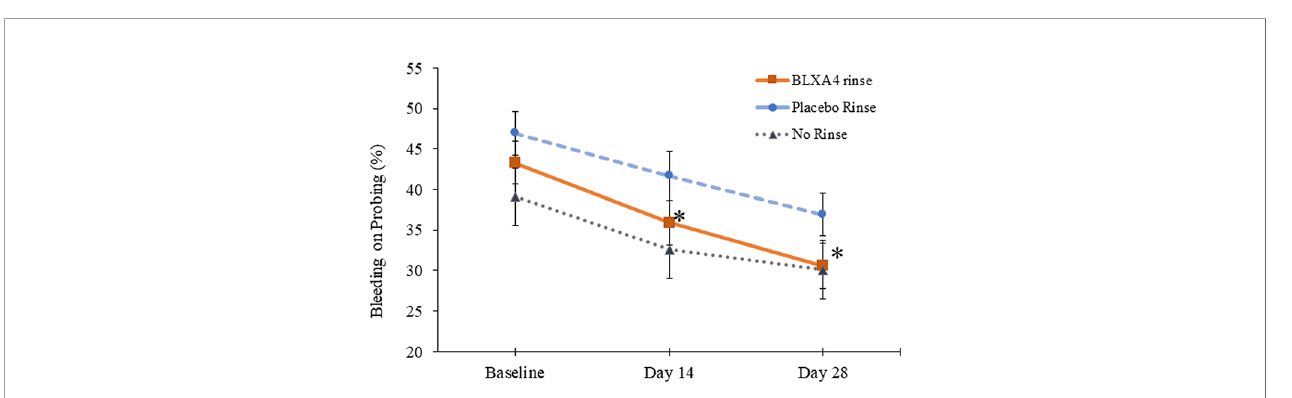
FIGURE 2 | Change in gingival index: Primary ef fi cacy endpoint. The key clinical endpoint associated with gingival in fl ammation was measured using the Modi fi ed Gingival Index (MGI) scored 0-4 (healthy-localized mild, generalized mild, moderate and severe). Change from baseline at Day 14 and Day 28 was compared between groups. The BLXA 4 group demonstrated greater reduction in gingival in fl ammation compared to placebo and no rinse groups. *Signi fi cant difference compared to placebo rinse (p<0.05); † Signi fi cant difference compared to placebo rinse and no-rinse (p<0.05); ^Signi fi cant difference compared to no-rinse (p<0.05) by repeated measures mixed models analyses. N=123 (BLXA4: 47, Placebo: 49, No rinse: 27